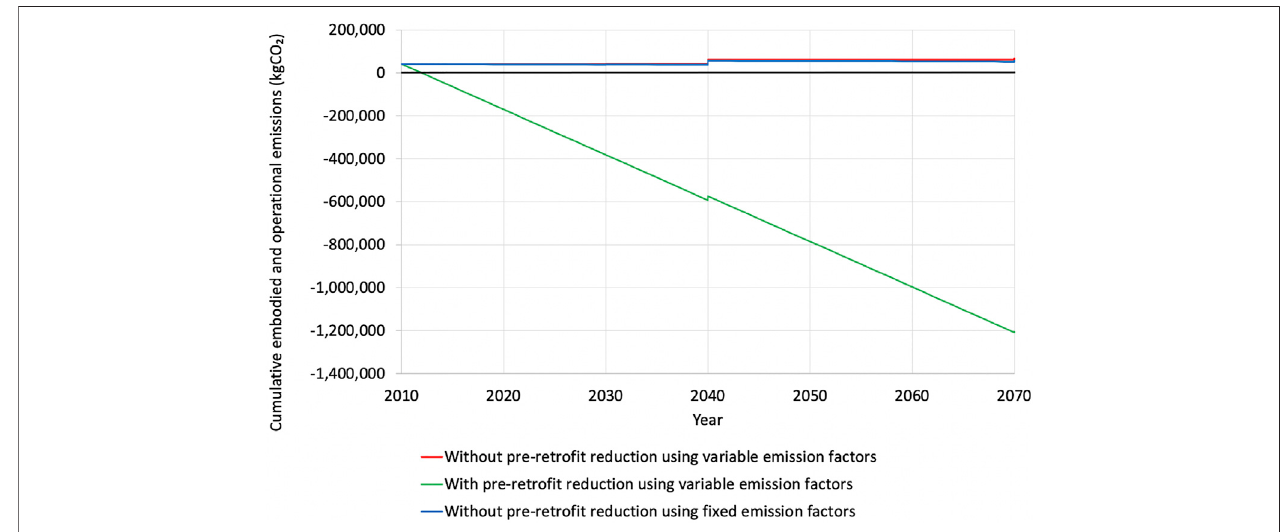
FIGURE 8 | Total cumulative